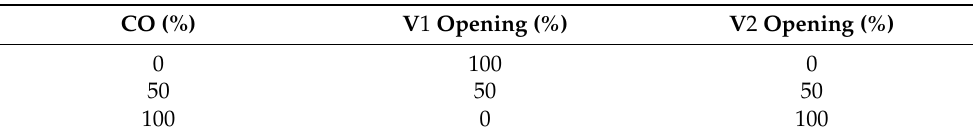
Figure 3. Simplified scheme of a bypass cooler, where manipulation of the hot bypass stream is allowed (the hot stream through the exchanger is adjusted accordingly in a complementary split- range arrangement). Table 1. Relation between controller output (CO) and valve opening in the complementary split-range temperature control arrangement. Notice that the two valves have opposite fail